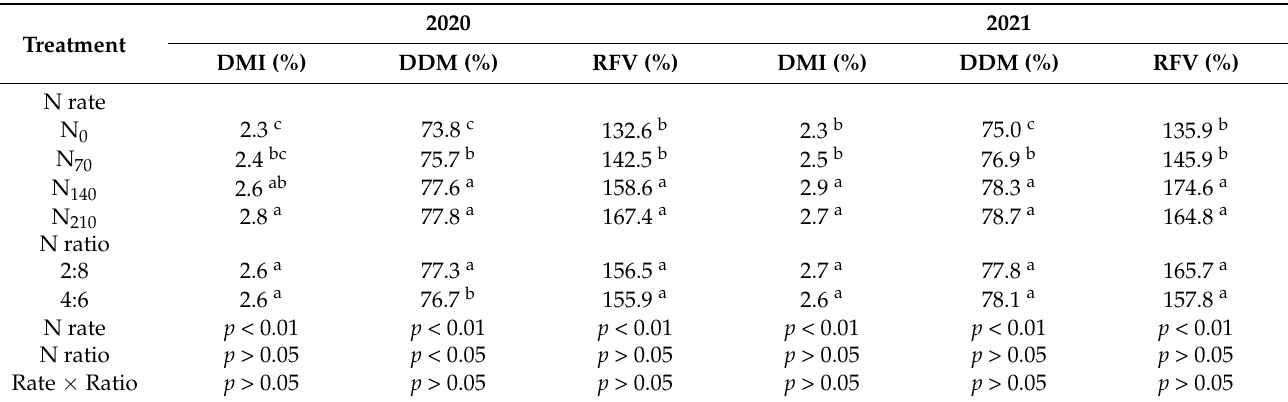
Figure 8. ADF of forage maize at harvest under different treatments in 2020 and 2021. Table 6. Dry matter intake (DMI), digestible dry matter (DDM), and relative feeding value (RFV) of forage maize under different